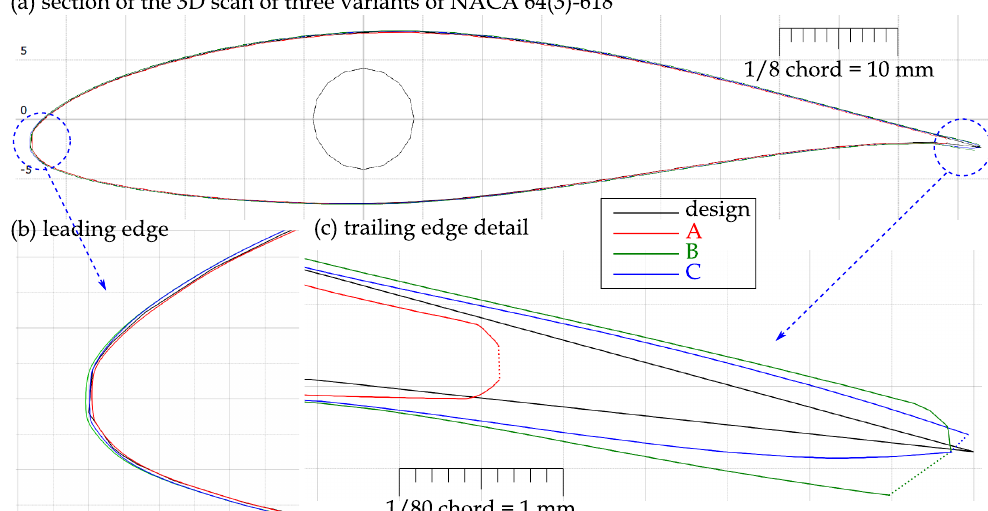
Figure 1. ( a ) Comparison of 3D scans of three manufactured realizations of the NACA 64-618 airfoil, which is depicted by a solid black line. The production details are in text. Panels ( b ) and ( c ) show the enlarged details of the leading and trailing edge,